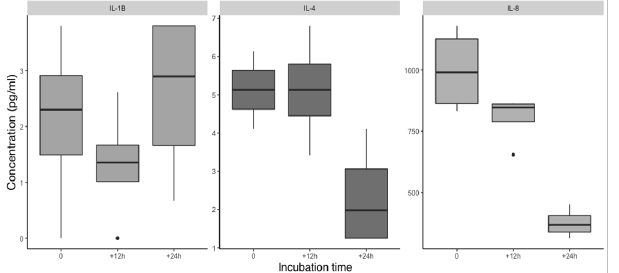
Figure 1. Incubation for 4 h - clarithromycin impact on pro- inflamma- tory mediators’ secretion. Figure shows the impact of clarithromycin, respectively, on IL-1β, IL-4 and IL-8 release by A459 cells. Before (incuba- tion time 0), after co-incubation (incubation time +4h), and 24 h after wash-out (incubation time +24h), cell culture supernatants were ana- lysed for the presence of the indicated cytokines by Luminex®. Values are expressed as mean ± SEM from 8 independent experiments.